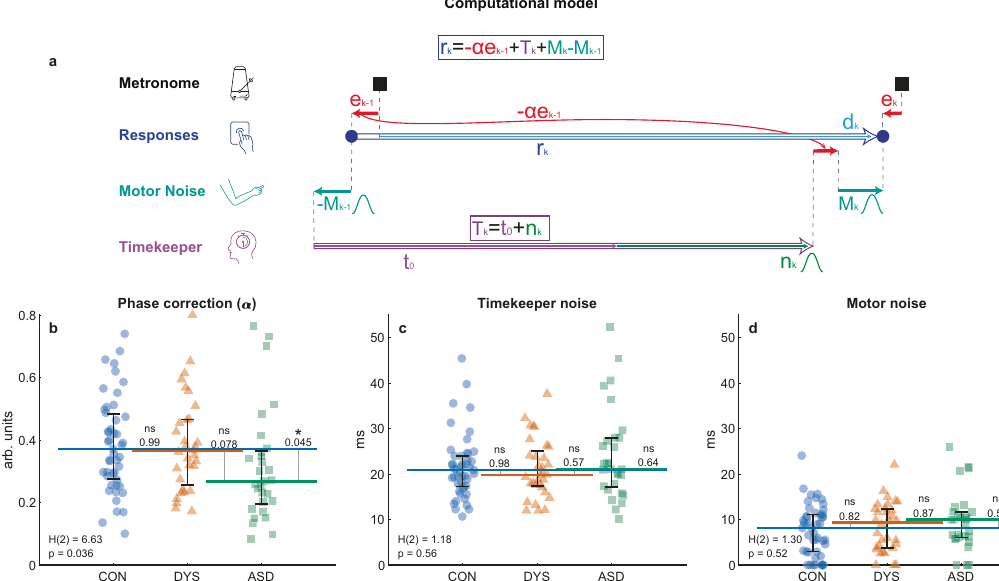
Fig. 3 Trial-by-trial computational modeling of isochronous tapping: Parameters estimated for each participant show that individuals with autism have reduced error correction and intact timekeeper and motor noise. a Schematic illustration of the computational model used to dissociate error correction mechanisms from poor timekeeping or motor noise 29,31,32 . Each tapping interval (blue empty arrow) is assumed to be the summation of three mechanisms: (1) error correction based on the previous asynchrony (marked in red, the magnitude of the correction is determined by the phase correction parameter α ) (2) timekeeping of the base tempo T k (composed of a fi xed t 0 , purple, plus the noise at tap k , n k , green), and (3) motor noise (turquoise). See also notations in Fig. 1a. Fitting was performed using the bGLS (bounded General Least Squares) estimation method 28 . b Error correction of phase difference — the fraction corrected ( α ) is signi fi cantly smaller in the ASD group. c Noise in keeping the metronome period, and d Motor noise do not differ between the groups. b – d Each block was modeled separately, and parameters were averaged over the two assessment blocks. The median of each group is denoted as a line of the same color; error bars around this median denote an interquartile range. Kruskal – Wallis H -statistic and corresponding p value are in the bottom-left corner; p values of comparisons between groups are next to the line connecting the groups ’ medians. CON control (neurotypical), DYS dyslexia, ASD autism. N = 108 subjects ( N CON = 47, N DYS = 32, N ASD = 29), one ASD participant was excluded due to a large number of missing taps (see Methods). Source data are provided as a Source Data fi